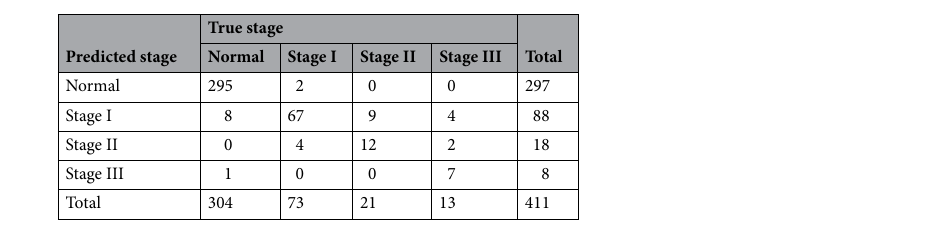
Table 1. Screening and staging performance on subregion level and subject level, respectively, in the test dataset.